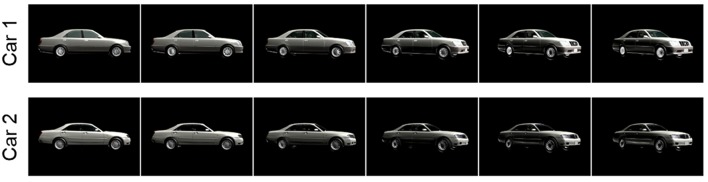
Partial image sequences from two different 3D video stimuli used in the Car Discrimination task. In each video, cars rotate from a side view to a 45-degree view. Car 1 and Car 2 are different models that are similar in appearance.